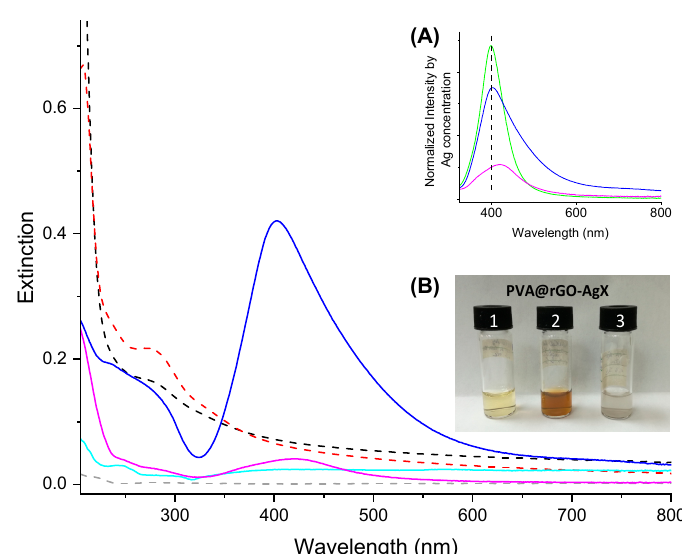
Figure 1. UV-vis spectra of water dispersions / solutions of PolyVinyl Alcohol (PVA) (grey dashed line, 0.3 mg / mL), PVA@GO (red dashed line, 0.3 mg / mL), PVA@rGO (black dashed line, 0.3 mg / mL), PVA@rGO-Ag1 (magenta line, 30 µ g / mL), PVA@rGO-Ag2 (blue line, 30 µ g / mL), PVA@rGO-Ag3 (cyan line, 30 µ g / mL). Inset ( A ): UV-vis spectra normalized by Ag weight content of AgNPs (green line), PVA@rGO-Ag1 (magenta line), PVA@rGO-Ag2 (blue line). Inset ( B ): Digital image of water dispersions (0.3 mg / mL) of PVA@rGO-Ag1 (vial 1), PVA@rGO-Ag2 (vial 2), and PVA@rGO-Ag3 (vial